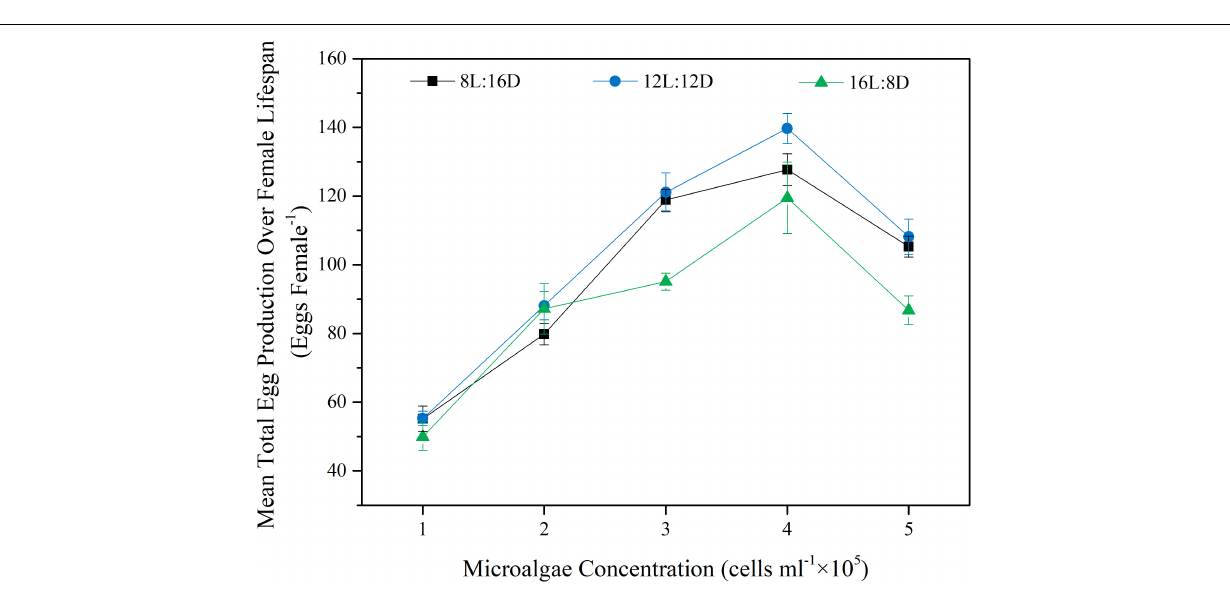
Figure 4 shows final population composition of B. amoyensis (eggs, nauplii, copepodites, female and male adults) at the end of the experiment. The maximum amount of nauplii and copepodite was reached under photoperiod of 8L:16D in all diet treatments ( Figure 4 , Table 1 ). Under photoperiod 12 h L:12 h D and 16 h L:8 h D, nauplii stage accounted for more than 50% of